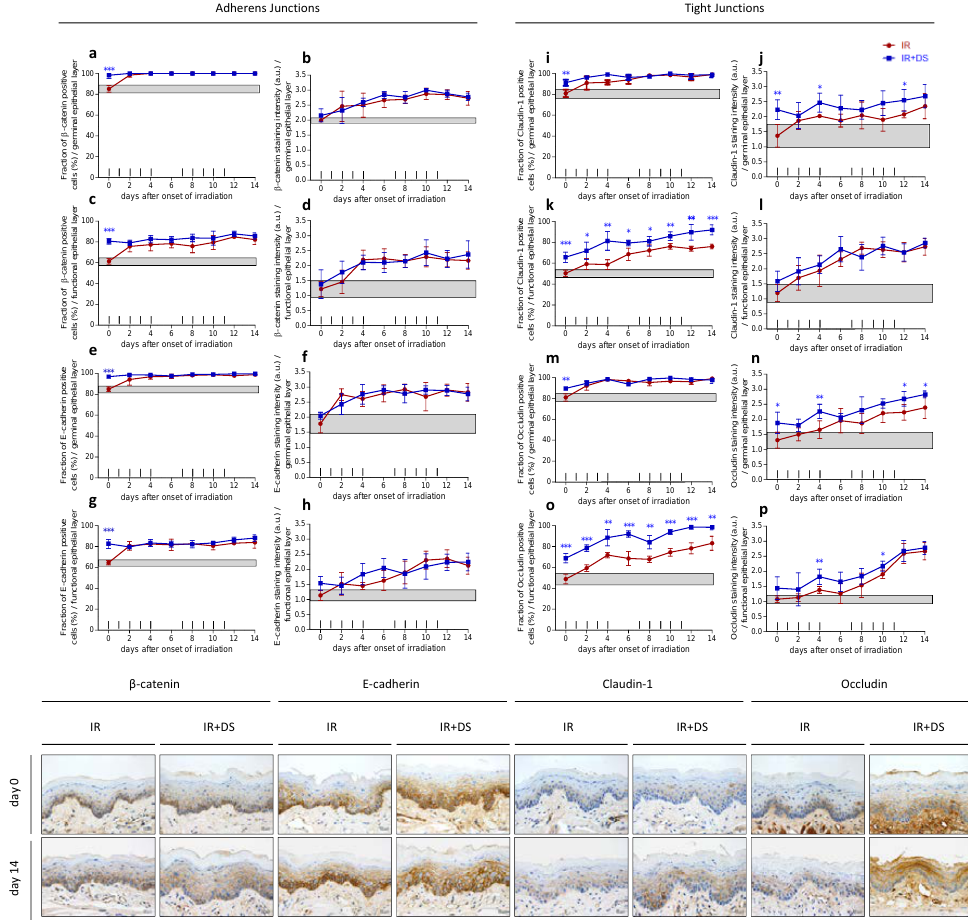
Figure 2. Effect of DS on irradiation-induced epithelial junctions. The relative number of adherens junction marker β -catenin and e-cadherin- ( a – h ) or tight junction marker claudin-1 and occludin positive epithelial cells ( i – p ) and their respective staining intensity were analyzed, in the germinal and functional compartments, respectively. Data points represent the mean of 5 animals, error bars indicate ±1 SD. The shaded areas illustrate the mean (±1 SD) from 5 control animals. The fractionation protocol is indicated on top of the abscissae. Histophotographs illustrate representative junction marker staining in on day 0 and after irradiation without and with DS on day 14 of the study period. * p ≤ 0.05, ** p ≤ 0.01, *** p ≤ 0.001, Scale bar = 20 µm.